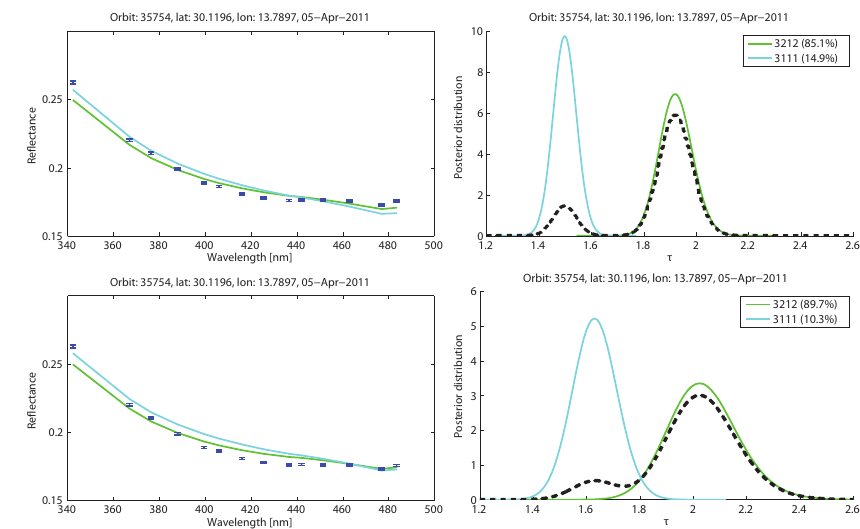
Fig. 8. Sahara dust storm, 2011. Upper row: the best two models when the model discrepancy is not included. Bottom row: the best two models when the model discrepancy is included. See Fig. 5 for more